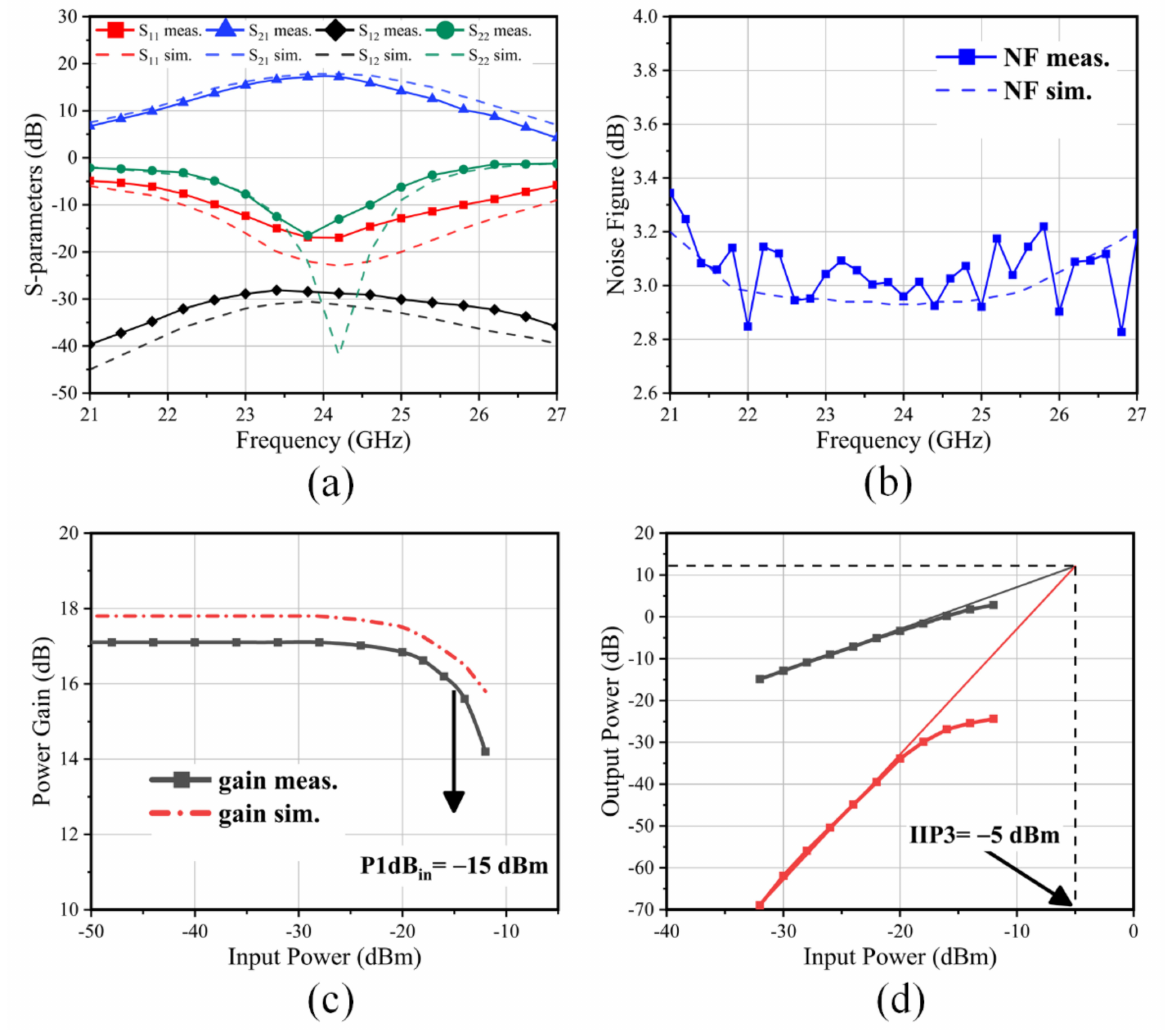
Figure 8. ( a ) S-parameters of LNA (low-noise-amplifier); ( b ) NF (noise figure) of LNA; ( c ) P 1dB of LNA; ( d ) IIP 3 of